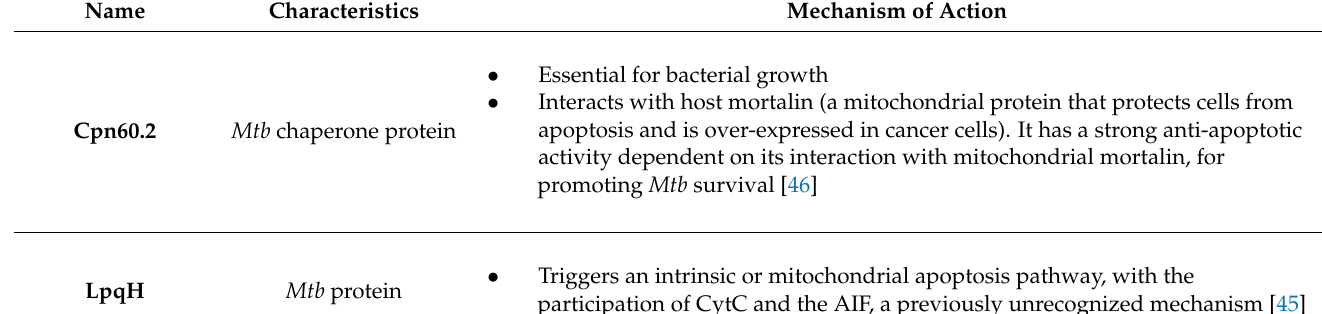
Table 2. Mtb molecules of direct or indirect mitochondrial